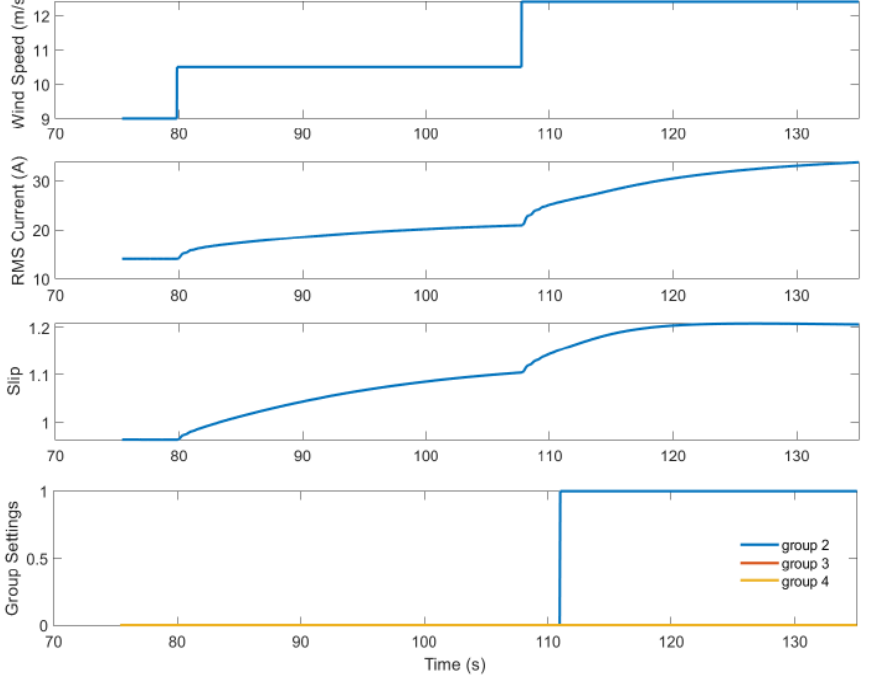
Figure 15. Real-time adjustment in protection settings for DFIG system.